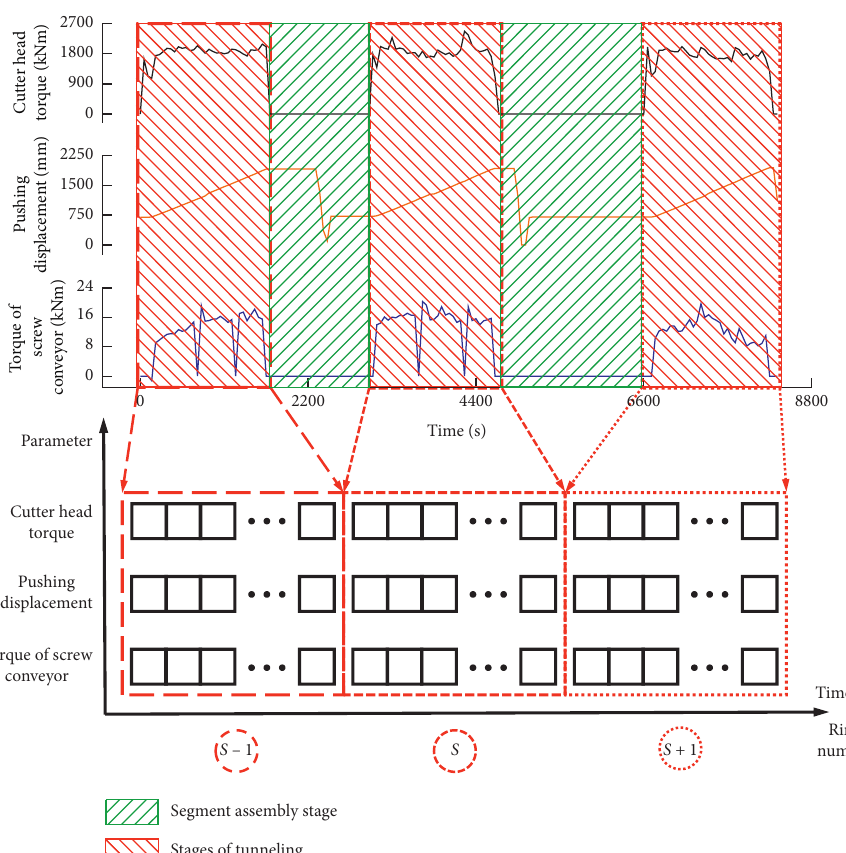
Figure 5: Multiring data of shield tunneling